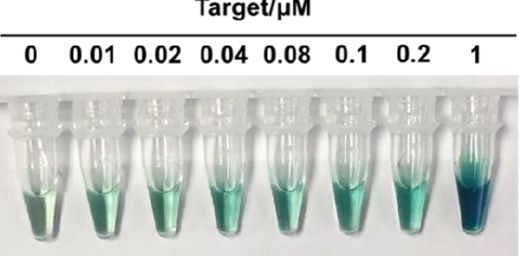
Figure 6. Sequences of the targeted norovirus GI conserved sequence (Target) and the two molecular beacons (P1 and P2), and the colorimetric observation of the target at different concentrations by 1 μ M P1 and 1 μ M P2 in colorimetric buffer.